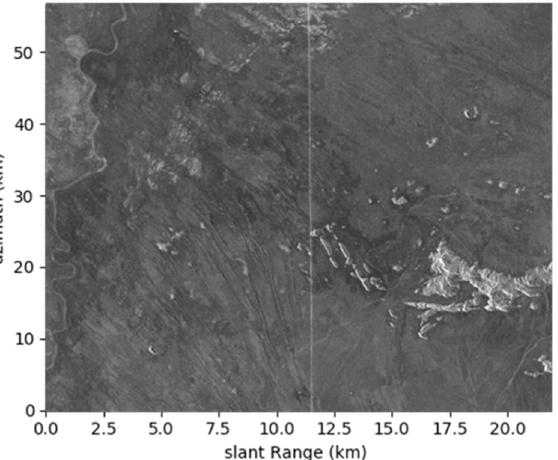
Figure 1. TerraSAR-X image acquired over Australia as an example of nadir echo appearing in a SAR image. The horizontal and vertical axes correspond to slant range and azimuth, respectively.